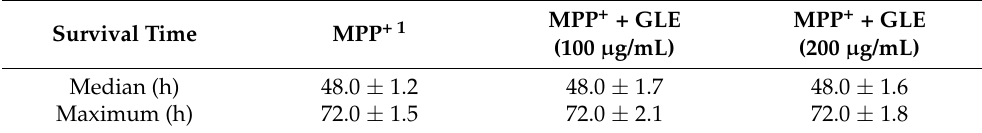
Table 2. Survival of daf-16 mutant C. elegans treated with MPP +